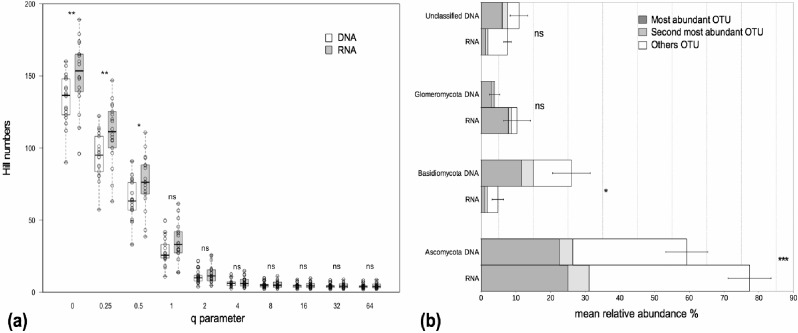
Alpha diversity and taxonomic composition of fungal communities in DNA and RNA fractions.(A) Distribution of Hill diversity numbers in DNA and RNA sequence data analyses. Different commonly used diversity indexes are special cases of Hill numbers (e.g., q = 0 corresponds to the species richness S, q = 1 corresponds to the exponential of the Shannon-Wiener diversity index, q = 2 corresponds to the inverse Simpson index). Asterisks indicate significantly different means between DNA and RNA fractions (paired t-tests). ‘ns’: p > 0.05, ‘*’: p < 0.05, ‘**’: p < 0.01. (B) Taxonomic composition of fungal communities in DNA and RNA fractions. Assignation of sequence taxonomy using SILVA database 115. Average relative sequence abundance (% ± se) of each phylum in the fungal kingdom for 19 samples. Asterisks indicate significantly different means between DNA and RNA fractions. ‘ns’: p > 0.05, ‘*’: p < 0.05, ‘***’: p < 0.001. The mean relative sequence abundances of the two most abundant OTUs are shown for each phylum. The most abundant OTUs in the DNA and RNA fractions were the same except for Basidiomycota. For this latter group, the second most abundant OTU in the RNA fraction was the most abundant OTU in the DNA fraction. There was just a slight difference in sequence number between the first and second most abundant OTU in the RNA fraction (420 and 322 sequences, respectively) and these two OTUs were assigned to the Agaricomycetes class.